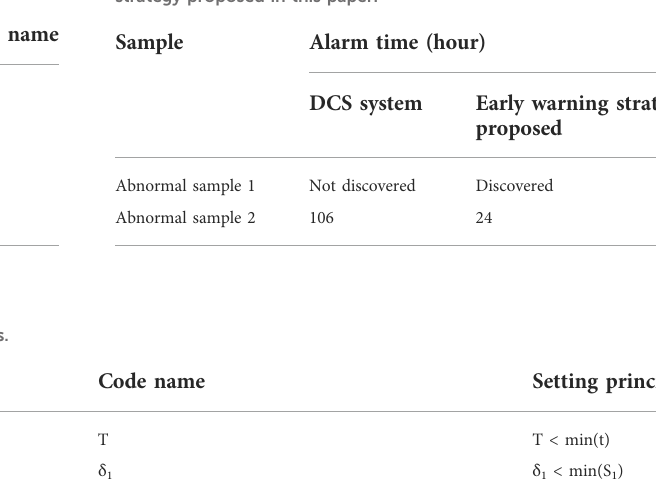
TABLE 2 The rules of model parameters.